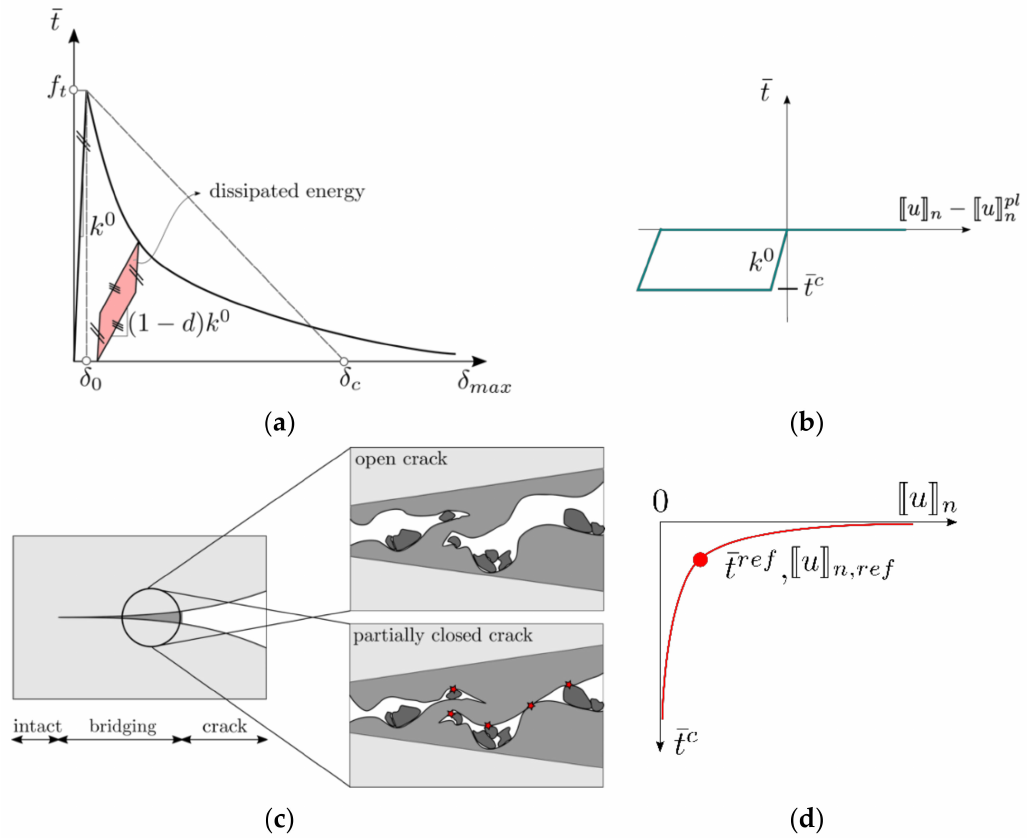
Figure 6. ( a ) Exponential softening relation used to model progressive stiffness and strength degradation due to cracking; ( b ) Schematic representation of the 1D plastic crack closure law; ( c ) Illustration of rough crack closure; contacts between asperities are marked with red stars; ( d ) hyperbolic relation between normal crack opening u n and the crack closure stress t c